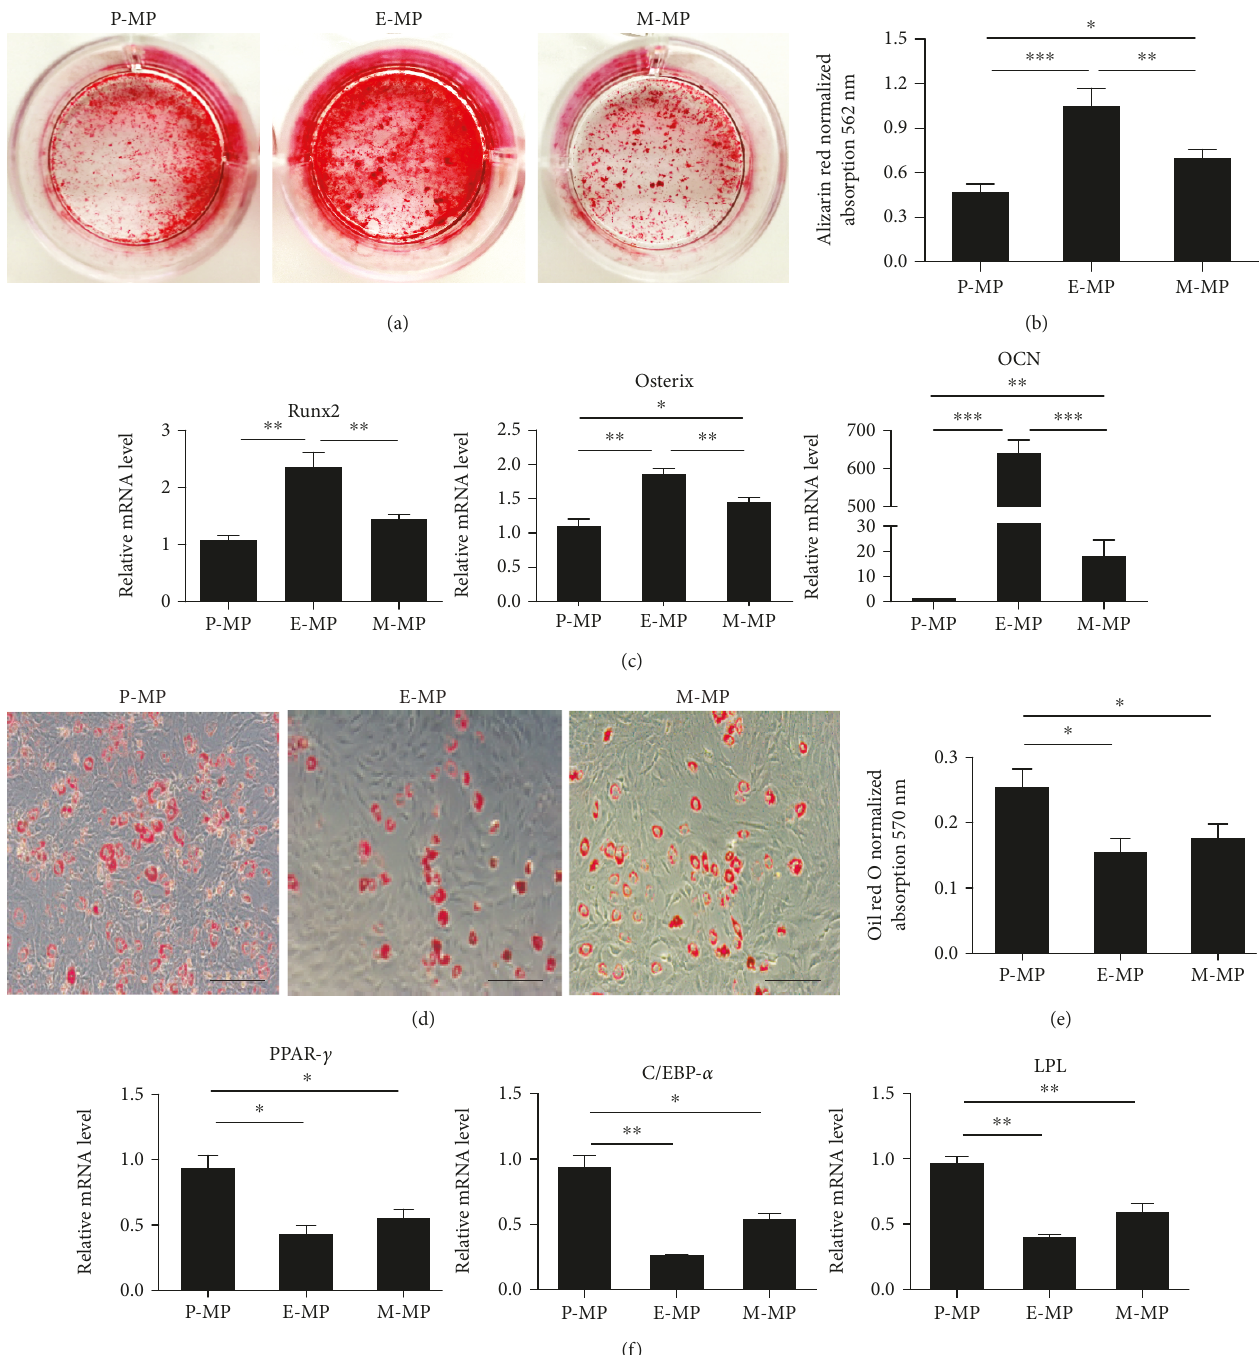
Figure 3: The bidirectional di ff erentiation potential of di ff erent MPs was distinct. (a) After culturing for 21 days in osteogenic di ff erentiation medium, alizarin red staining was performed. (b) Quanti fi cation of the mineralized matrix was measured. (c) The expression of osteoblast marker genes was detected by qRT-PCR. (d) After culturing for 14 days in adipogenic di ff erentiation medium, oil red O staining was performed. Scale bar, 100 μ m. (e) Quanti fi cation of intracellular oil red O was measured. (f) qRT-PCR was performed to detect the expression of adipocyte marker genes. Data was shown as mean ± SD . ∗ p < 0 05 ; ∗∗ p < 0 01 ; ∗∗∗ p < 0 001